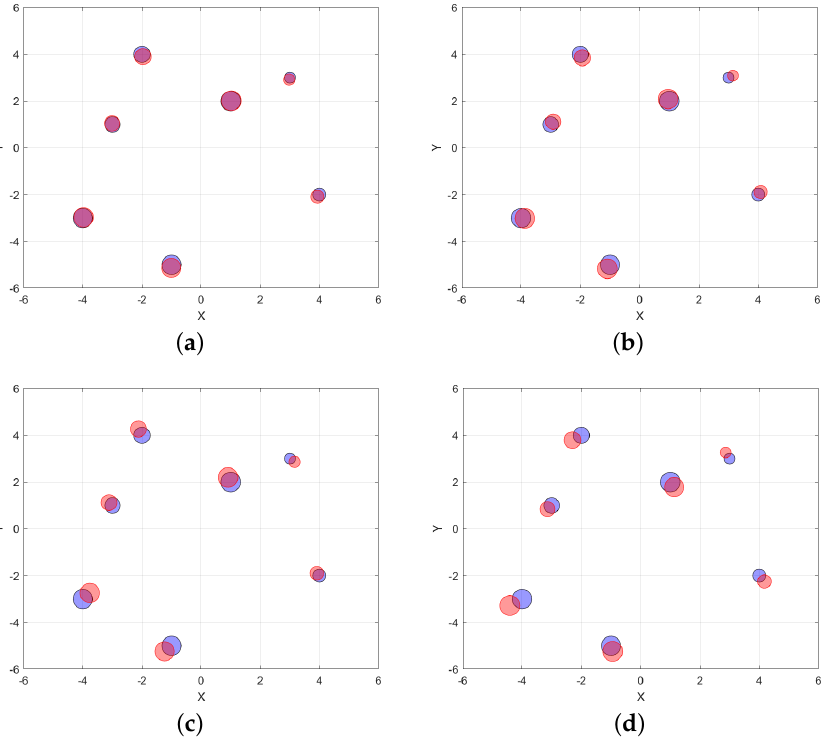
Figure 11. The reconstructions of the multi-sources with different observation apertures. Here, ( a – d ) represent the